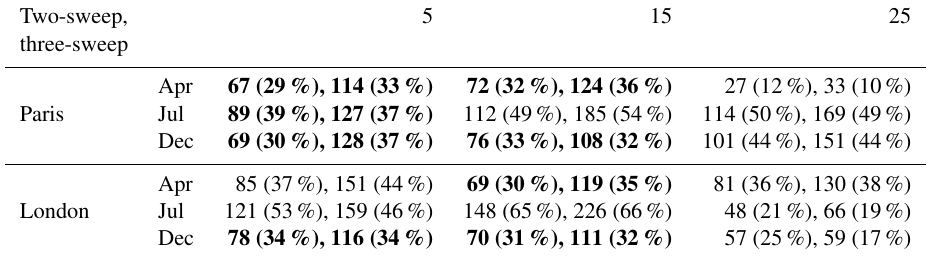
Table A1. The number of cloud-free observations and their percentage relative to the total number of observations for the two-sweep (228) and three-sweep (342) modes in Paris and London. Bold numbers mark the dates that we artificially halve the cloud cover from 1 to 0.5; otherwise, there are no cloud-free samplings at 12:00UTC on those dates.